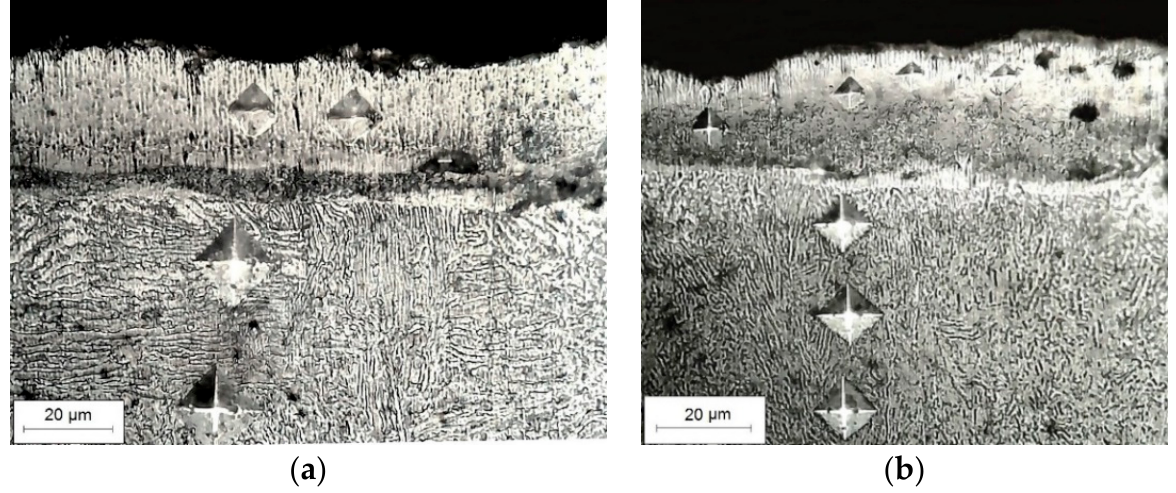
Figure 4. Microstructure of the coating on steel C45, obtained by ESD with the supply of a mixture of titanium and graphite powders to the MEP: ( a ) discharge energy Ep = 0.3 J and ( b ) discharge energy Ep = 0.9 J.